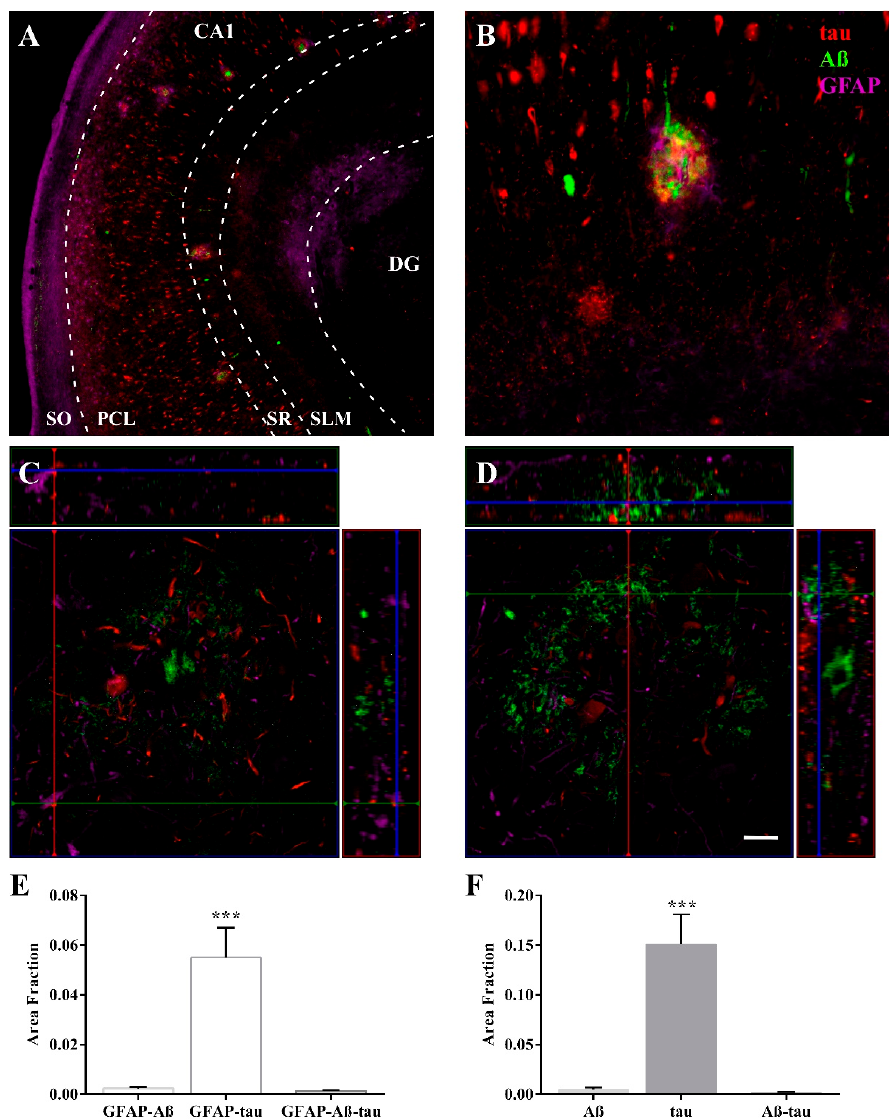
(Figure 4E) (one-way ANOVA F (2, 12) = 19.62, p value = 0.0002). Furthermore, quantifica- tion of pathological protein expression using the AFF method revealed that the tau-positive area was larger than the A β -positive area (Figure 4F) (one-way ANOVA F (2, 12) = 23.92, p value < 0.0001).